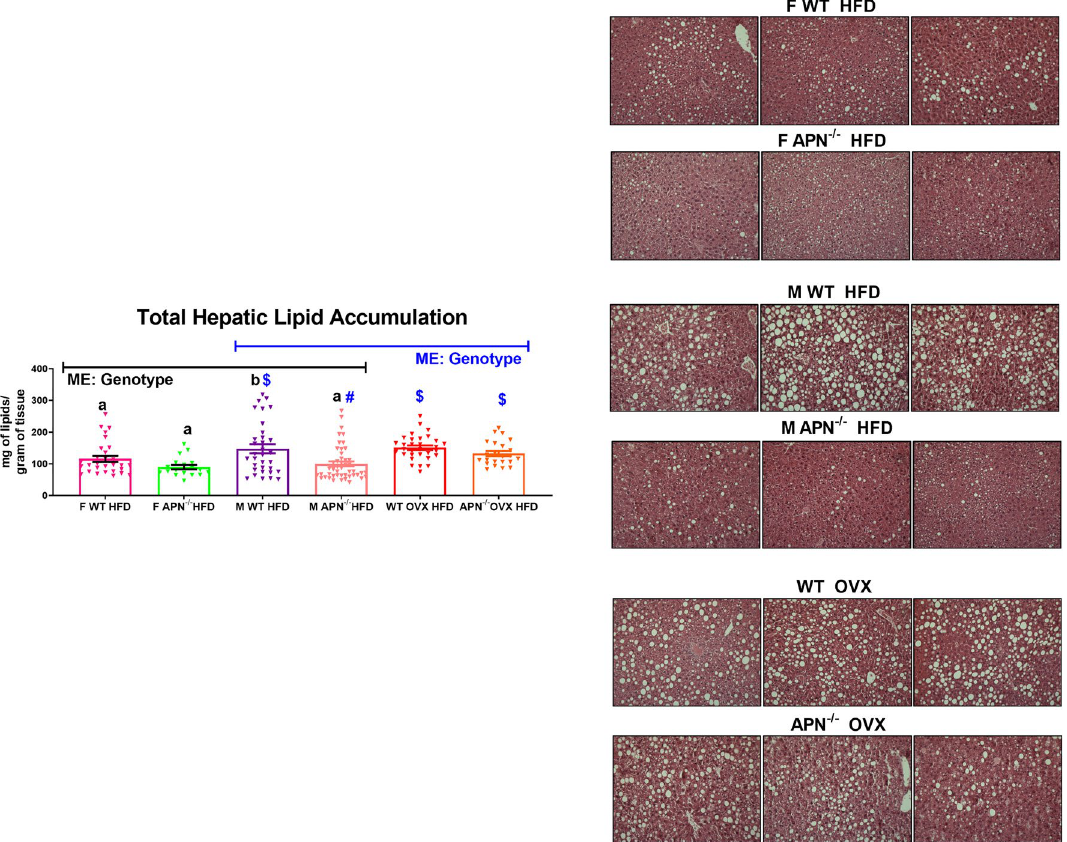
Figure 7. Adiponectin deficiency dramatically reduces hepatic steatosis in male mice. After 16 weeks of HFD, the liver was assessed for hepatic lipid accumulation and was histologically examined via H&E staining (n = 19–46). Data is presented as mean ± SE. Bar graphs not sharing a common letter or symbol are significantly different from one another (P < 0.05). ME = Main